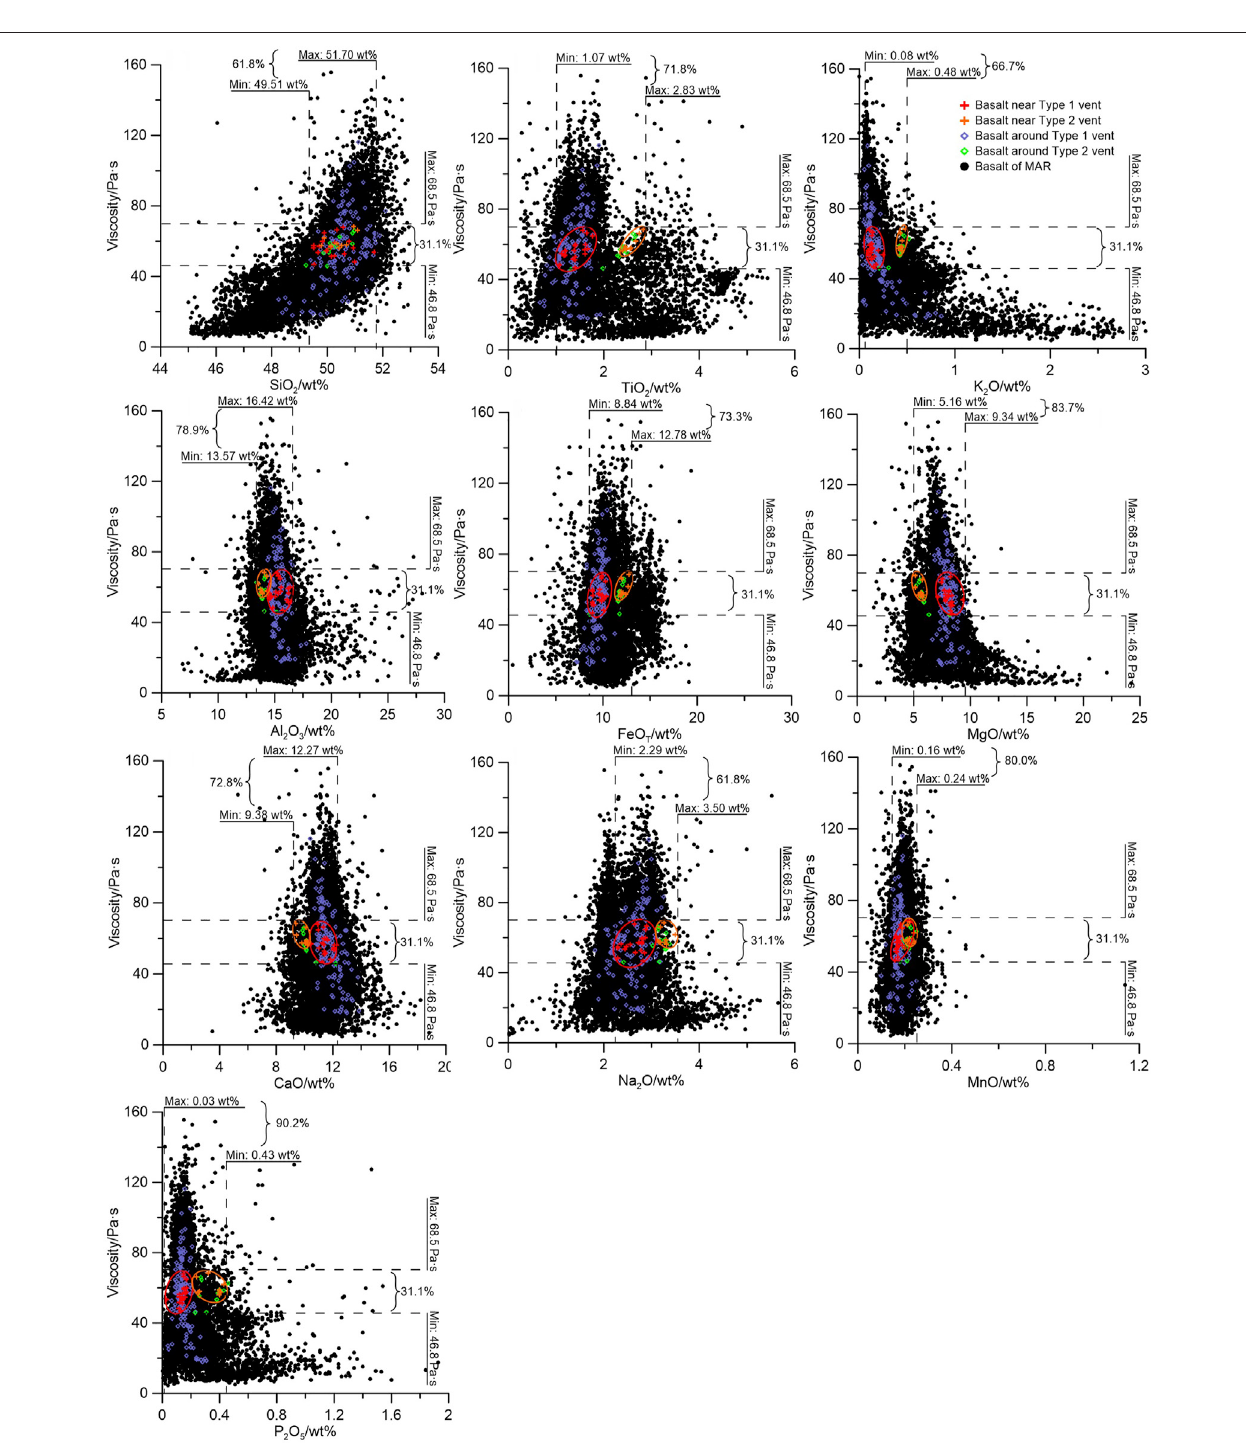
FIGURE 11 | Major-element – viscosity scatter diagrams for BNV and MAR basalt. The BNV vents are divided into Type 1 (vents 1 – 6, enclosed by red circles) and Type 2 (vents 7 – 11, enclosed by orange circles). The dashed lines delineate the upper and lower values in BNV, and the annotations report the proportions of MAR samples in each